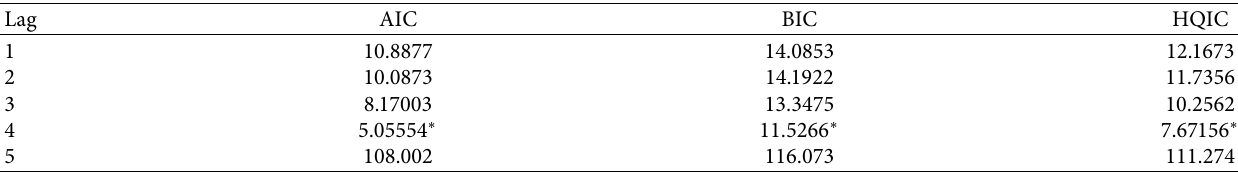
Table 10: Test restuls of the optimal lag order.